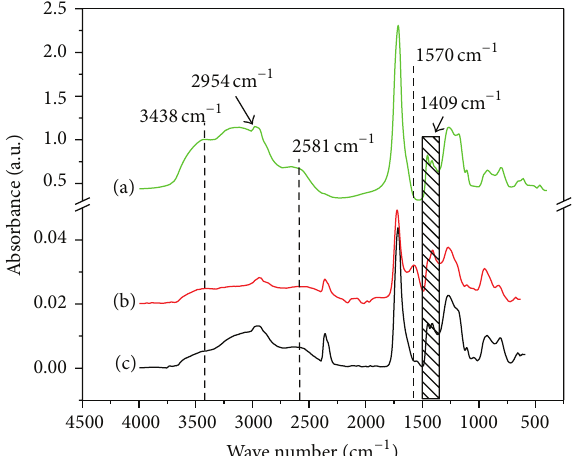
Figure 5: FTIR spectrum of (a) pure PAA, (b) PAA/Ag nanocom- posites, and (c) PAA/AgNO 3